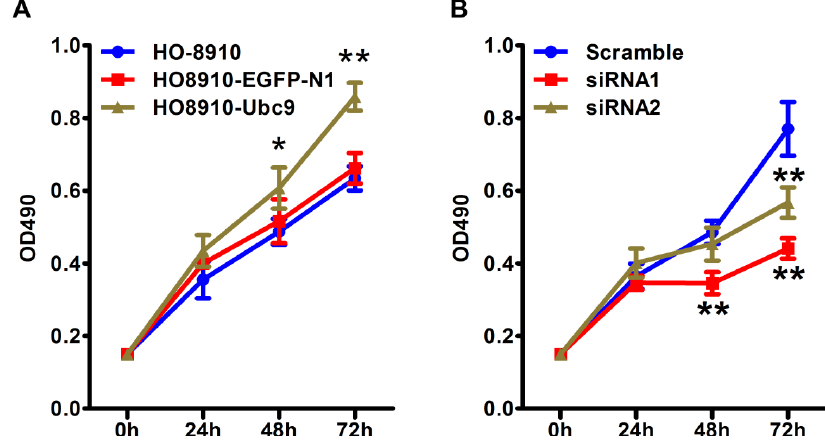
Figure 4. Effect of Ubc9 on HO-8910 cell proliferation. ( A ) HO-8910 cells were stably transfected with Ubc9 expressing plasmid or vectors and cell viability was detected with MTT assay. Data are means ± SEM from 3 separate experiments. * p < 0.01, ** p < 0.001 compared with HO-8910 cells; ( B ) HO-8910 cells were transfected with siRNAs targeting Ubc9 or scramble siRNA and cell viability was detected with MTT assay. Data are means ± SEM from 3 separate experiments. ** p < 0.001 compared with scramble transfection.